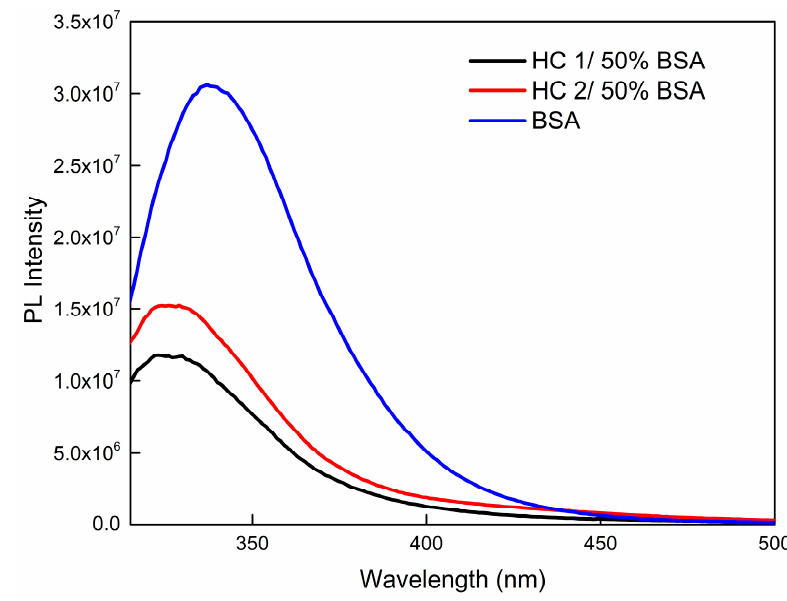
Figure 11. Fluorescence spectra of selected HC–BSA co-assemblies.